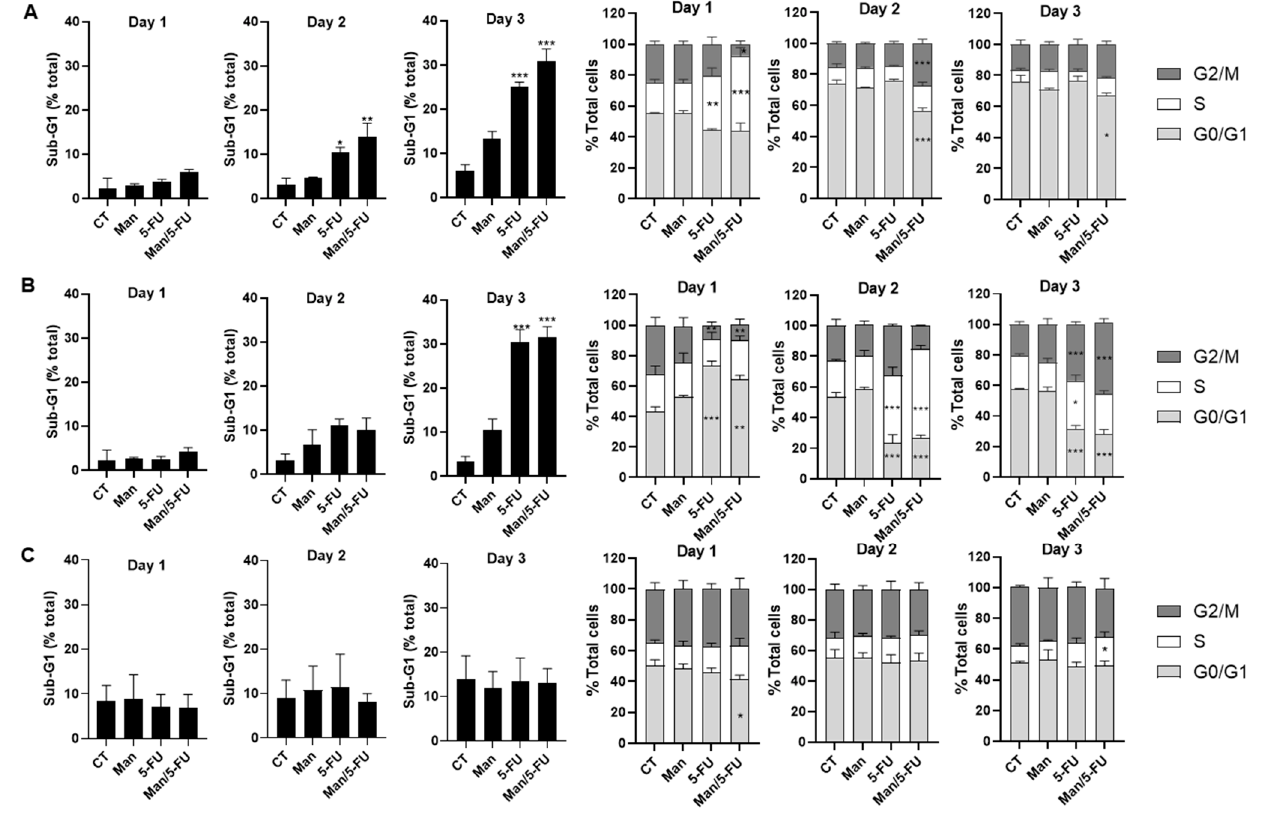
Figure 7. Mannose and 5-FU treatments induce S-phase arrest and increase sub-G1 cell accumulation in colorectal cancer cells. Cells were treated with mannose (50 mM) and/or 5-FU (5 µ M) for up to 3 days. ( A ) HCT116, ( B ) HCT116 p53 − / − , and ( C ) HCT116-5FUR cells. The sum of G0/G1, S, and G2/M phases is a percentage of non-dead cells. Percentage cells in the G0/G1 phase are calculated as 100 − (S + G2/M). Results represent the average of three independent experiments (±SEM). Significance from the control is indicated by * p < 0.05, ** p < 0.01, and *** p < 0.001.